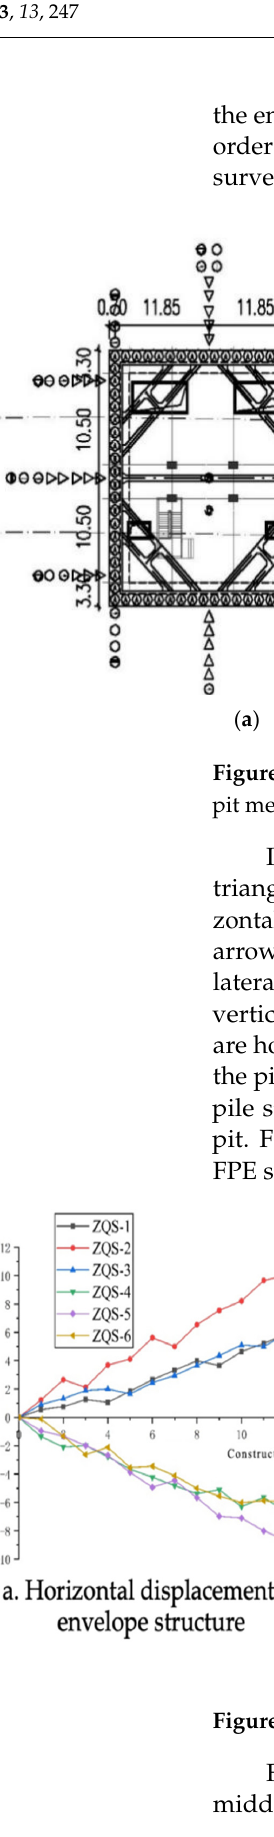
middle of the north side of the pit for different FPE steps (e.g., the green line represents before excavation; the blue triangular line represents excavation to 0.5 m below the second course; the light blue square line represents excavation to 0.5 m below the third course; the brown line represents excavation to 0.5 m below the fourth course; the dark blue square line represents excavation to 0.5 m below the fifth course; and the red line repre- sents excavation to the bottom of the foundation pit). Figure 13c shows the horizontal displacements of the enclosure pile body in the middle of the east side of the pit for dif- ferent FPE steps (e.g., the black line represents before excavation; the blue square line rep- resents excavation to 0.5 m below the second course; the red line represents excavation to 0.5 m below the third course; the dark blue star line represents excavation to 0.5 m below the fourth course; the brown line represents excavation to 0.5 m below the fifth course; and the green line represents excavation to the bottom of the foundation pit). During the excavation of the foundation pit, the excavation side of the pit was always on the east side of the pit. So, the overloading of the soil pile makes the cumulative dis- placement on the east side become large. The displacement of the crown beam on the east side is positive and moves toward the inside of the pit. The force is transferred to the north side through the concrete support, which makes the crown beam on the north side move out of the pit. After the excavation of the foundation pit was completed, the accumulated displacement on the east side was 2.03 mm larger than that on the north side. It can be seen that the ground overload has a large impact on the displacement of the enclosure structure, and the soil on the ground should be transported away in time after excavation. As the excavation depth of the pit increases, the maximum point of lateral displacement also changes. The position of the maximum point keeps moving downward, and the amount of pile displacement change finally shows a shape, large in the middle and small at both ends. According to the basic principles of geomechanics: this is caused by the point of combined earth pressure located at 1/3 of the excavation depth of the foundation pit from the bottom of the foundation pit. The horizontal lateral displacement of the enclosure structure gradually accumulates with the increase of the excavation depth of the pit. Generally, it reaches the maximum when the pit is excavated to the design elevation at the bottom of the pit. The authors plotted the monitored and simulated values of the horizontal lateral movement of the en- closure on the east side of the pit on a graph to compare and observe its trend, as shown in Figure 14.